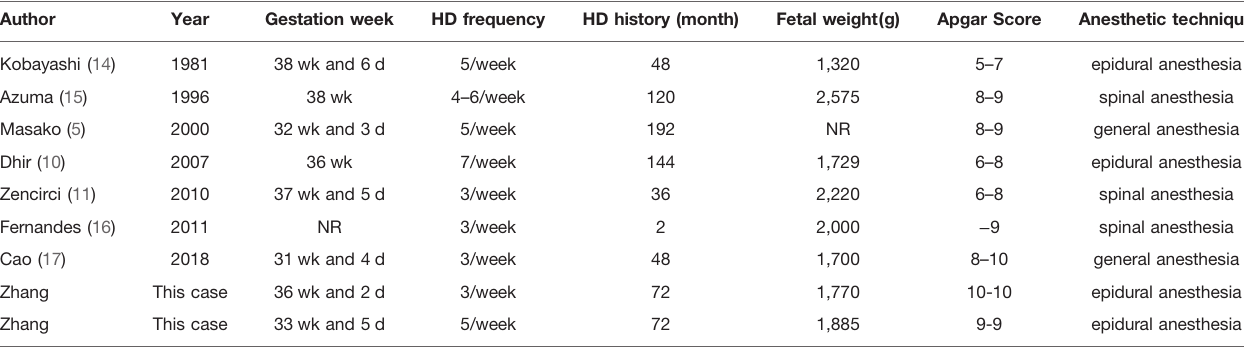
TABLE 3 | Pregnancy cases in patients with CRF requiring HD in